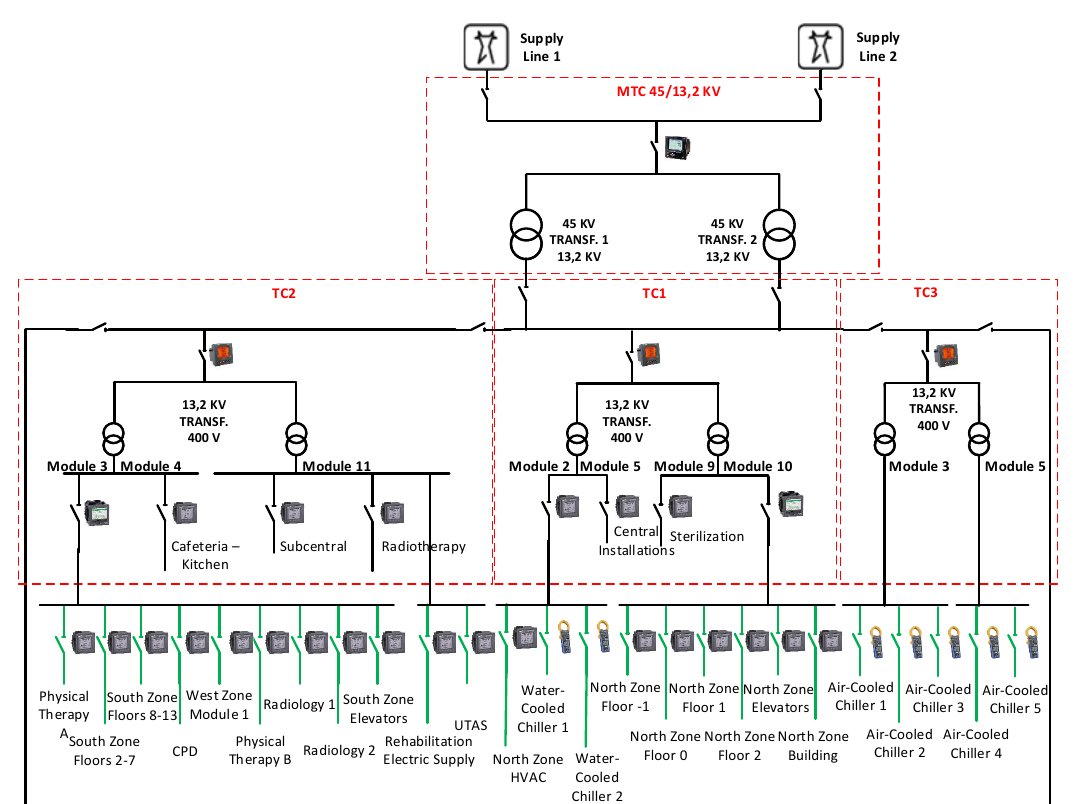
Figure 2. Single-line diagram of the electricity supply and meters at the León University Hospital. The distribution panels are dependent on the TC1 feed different areas of the north zone of